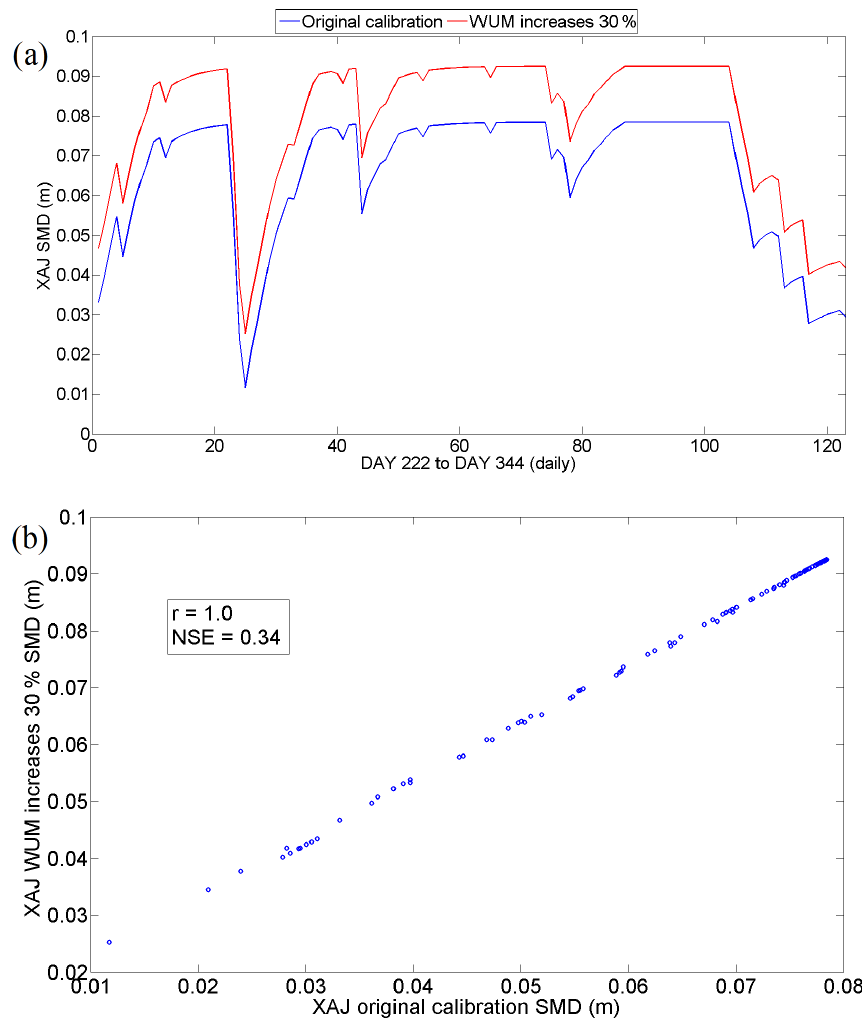
Figure 11. SMD variations from the manipulated XAJ calibration (i.e., the WUM parameter is increased by 30%) and its original calibration.